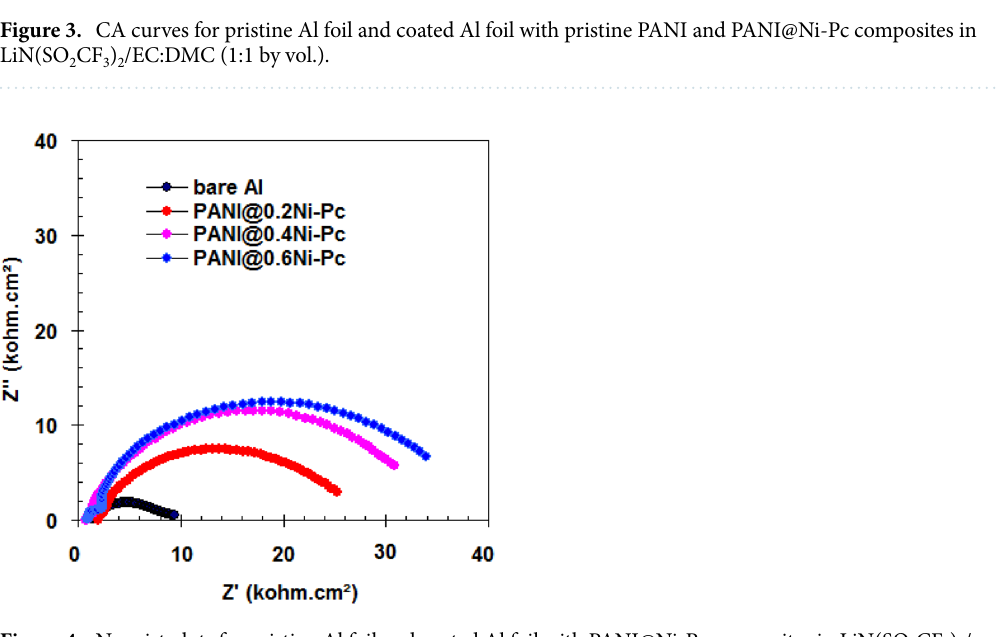
Figure 4. Nyquist plots for pristine Al foil and coated Al foil with PANI@Ni-Pc composites in LiN(SO 2 CF 3 ) 2 / EC:DMC (1:1 by